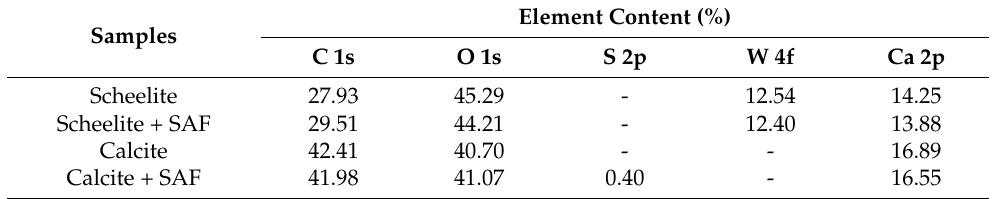
Table 2. Element concentrations on the scheelite and calcite surface. treated with and without SAF. Samples